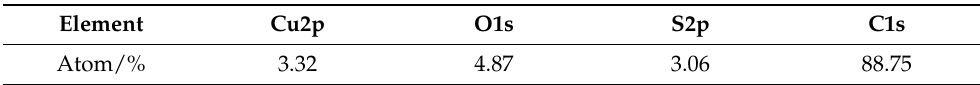
Table 4. Chemical valence and atomic percentage of peak elements in oil at the sliding speed of 119 mm/s.